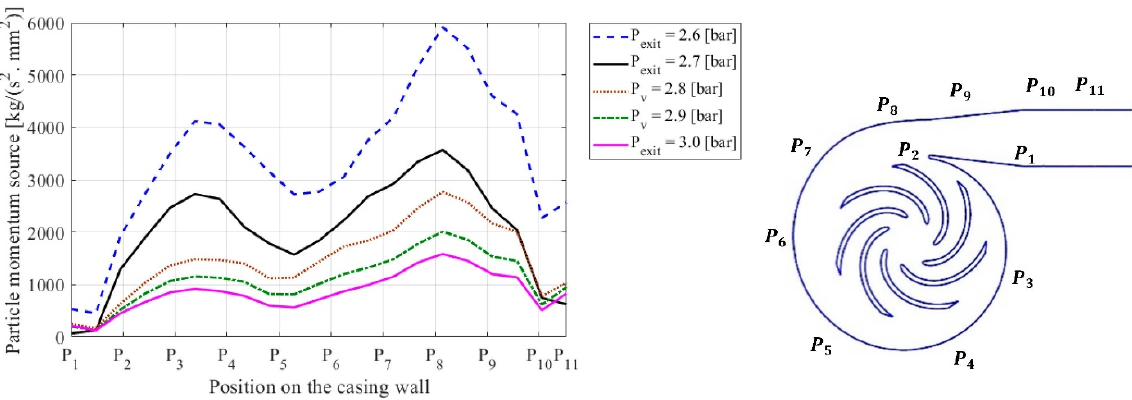
Figure 18. Trends of the particle’s momentum source along the casing wall with different values of exit pressure heads.